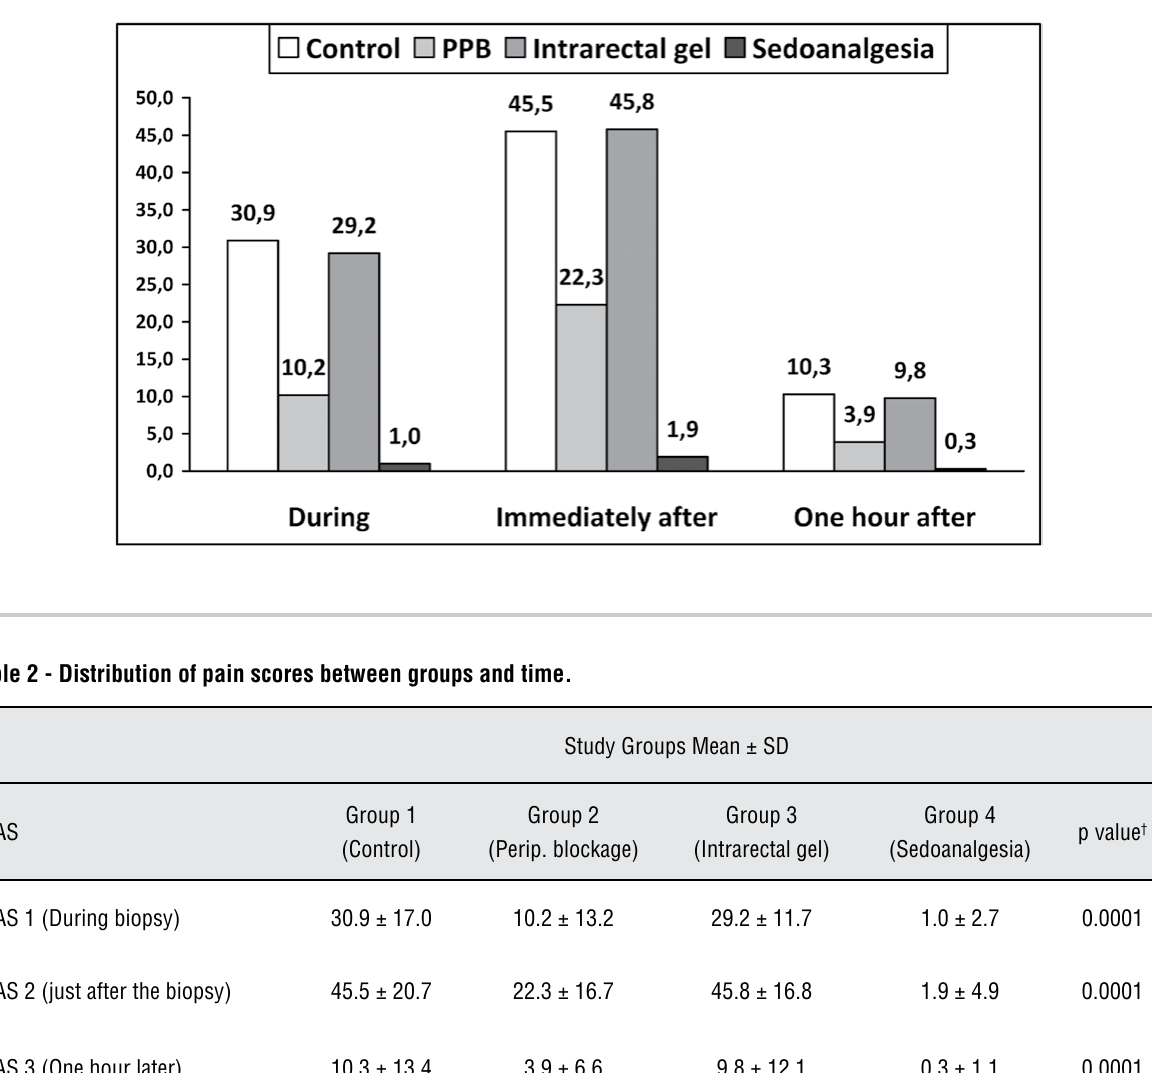
Figure 1 - Distribution of vAs pain scores along time according to